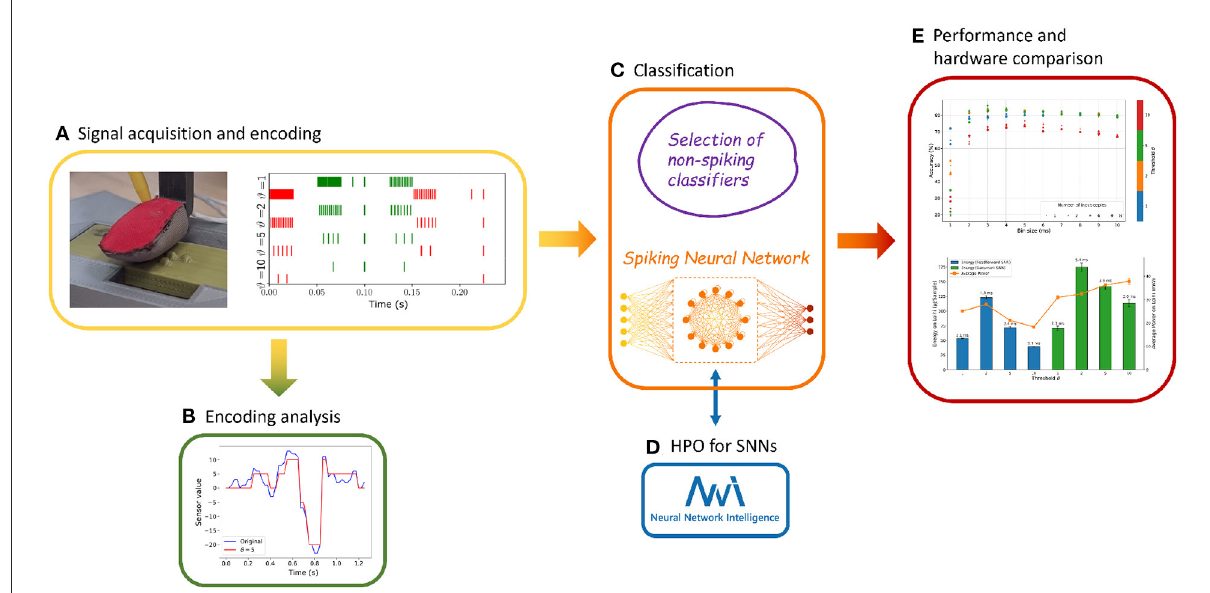
FIGURE1 The workflow is summarized in five steps. Dataset acquisition and signal encoding (A) with analysis of information content and reconstruction loss (B) . Different non-spiking classifiers are identified and employed to produce references for the proposed RSNN (C) , with the latter undergoing a hyperparameter optimization (D) . Finally, performances are evaluated, accounting for different metrics and hardware implementations (E)